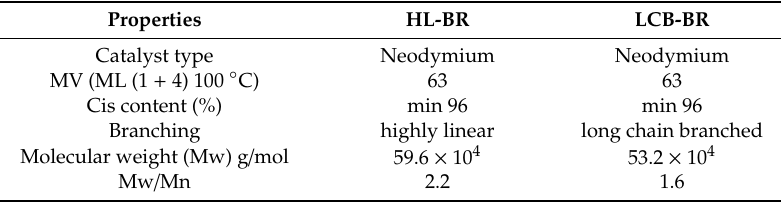
Table 1. Properties of butadiene rubber used in this research.